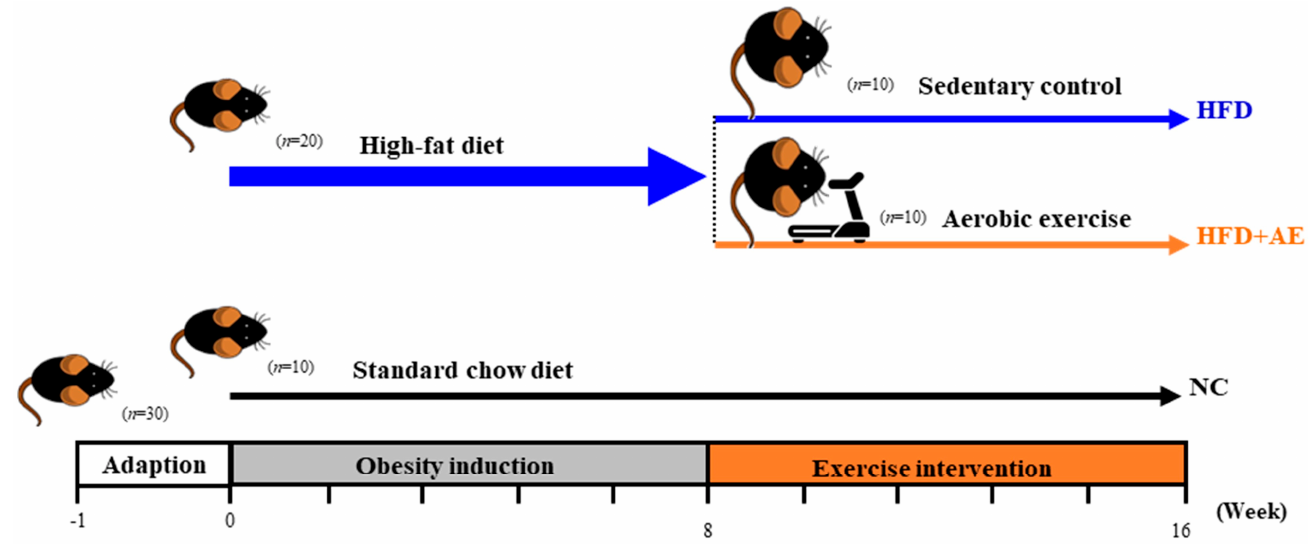
Figure 8. Experimental design (AE—aerobic exercise, HFD—high-fat diet, NC—normal control).